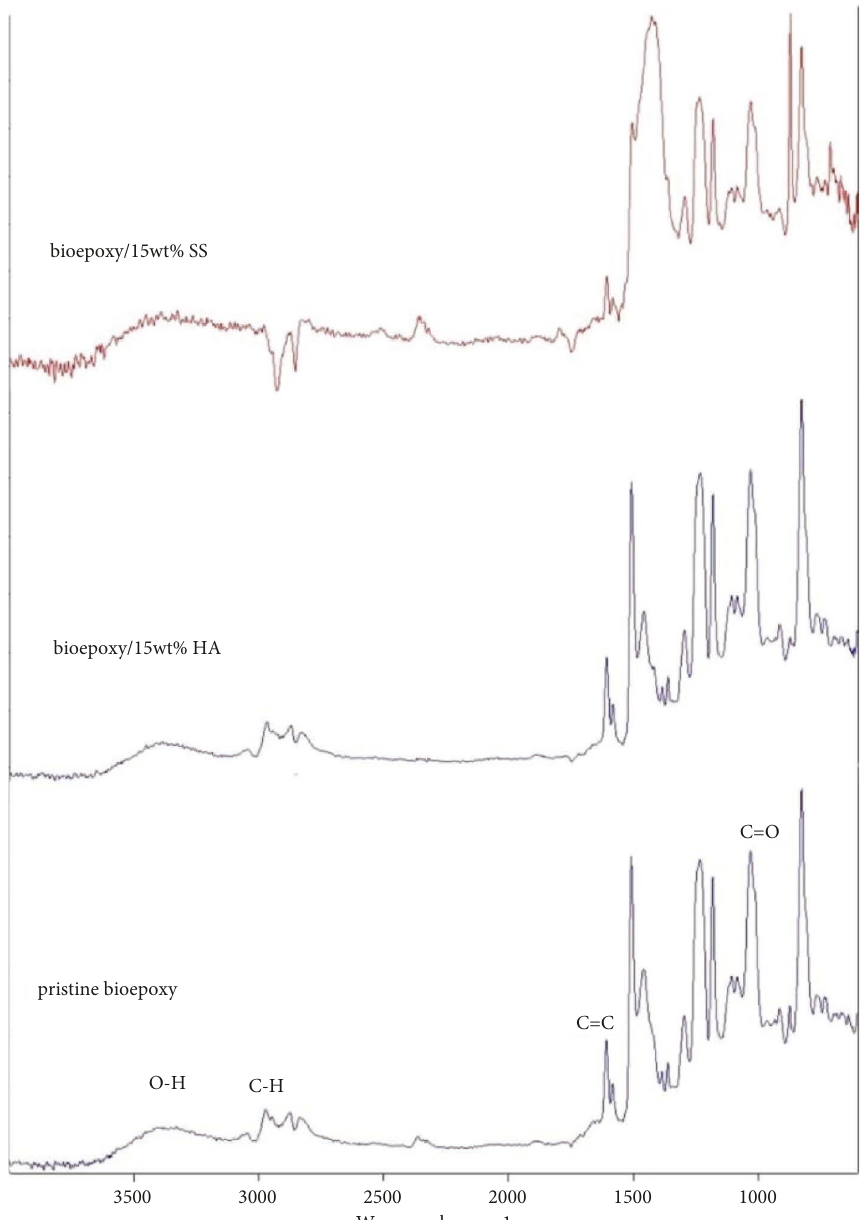
Figure 7: FTIR spectra of pristine bioepoxy, bioepoxy/15wt% HA nanocomposite, and bioepoxy/15wt% SS